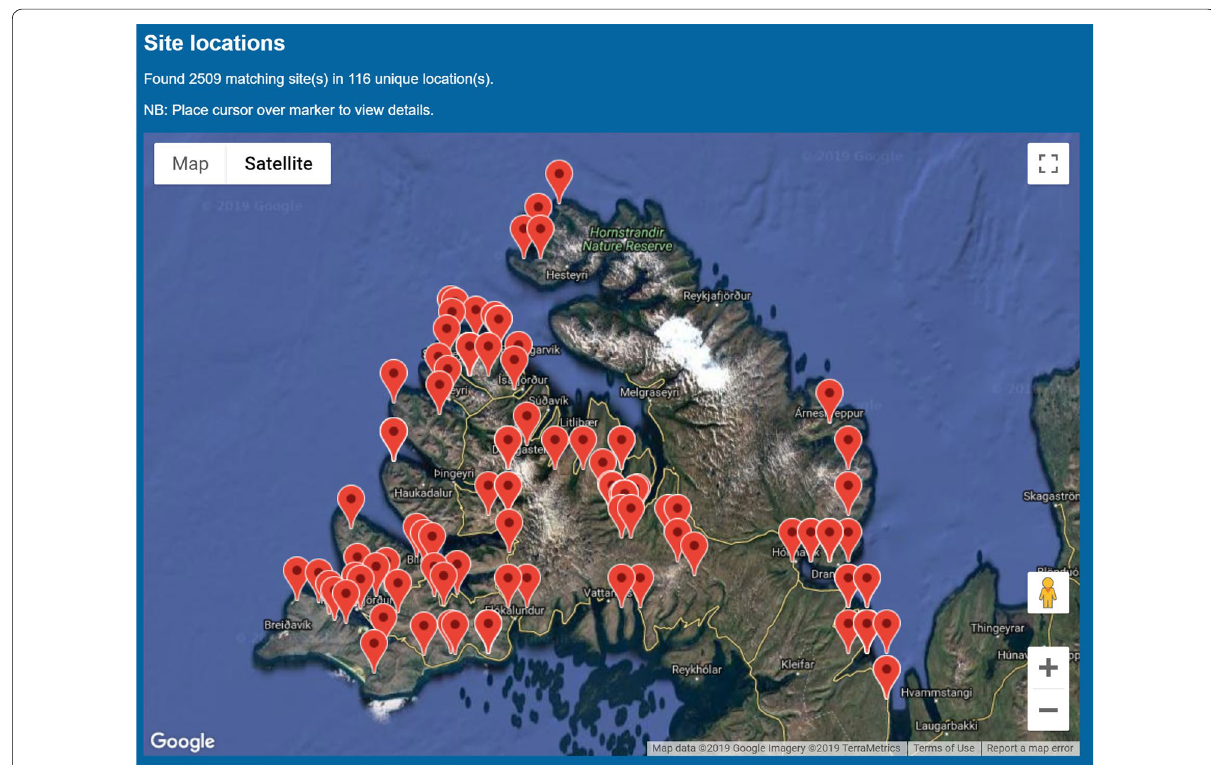
Fig. 4 Example site location map. Screenshot of an interactive location map generated by an ICEPMAG query (all sites in the Westfjords region)